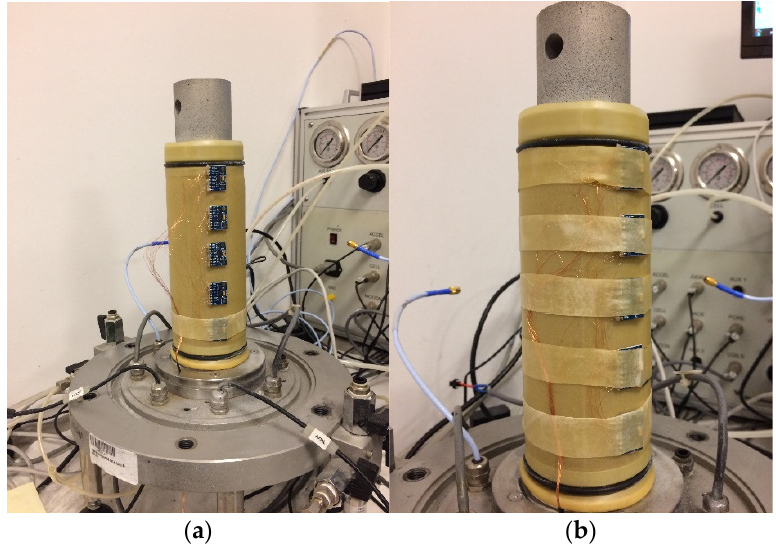
Figure 9. Experimental setup: ( a ) Modified RC device with five accelerometers attached to the membrane on the specimen surface; ( b ) The accelerometers were stabilized with elastic bands.